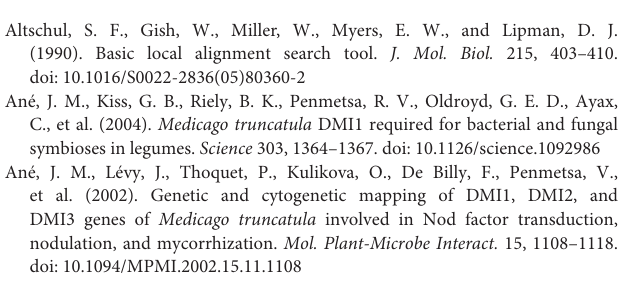
Supplementary Table 3 | Summarized G. max DMI genes expressed in syncytia. Gene families and syncytium expression profiles were presented in